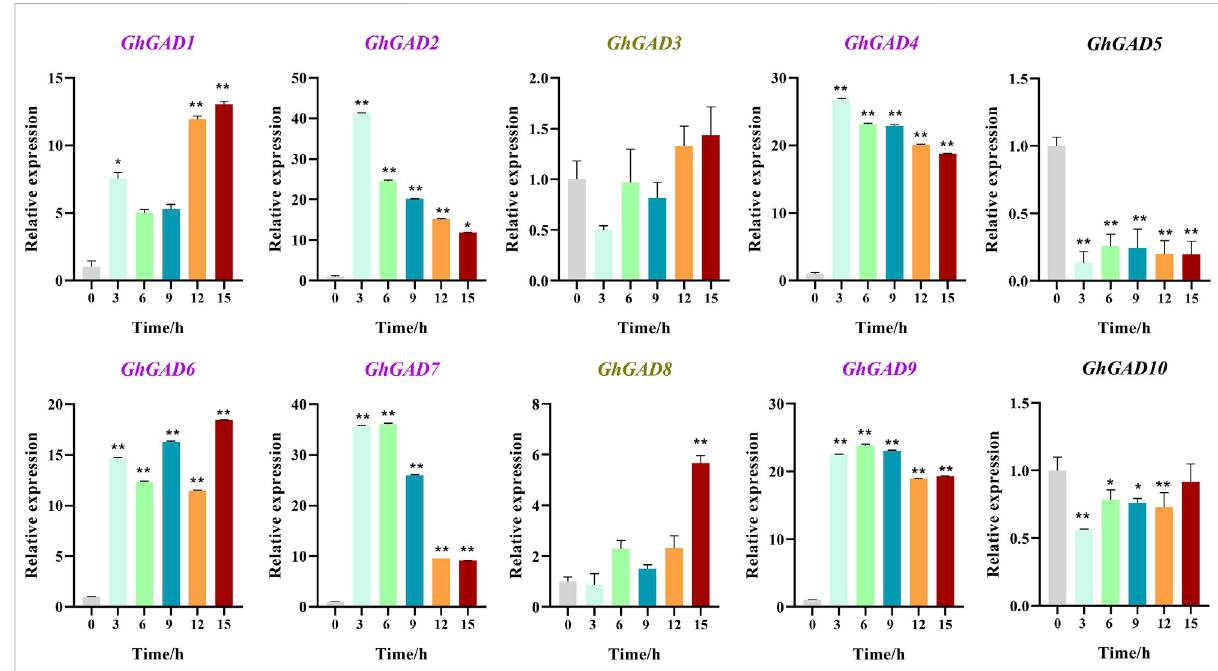
FIGURE 8 Expression analysis of GhGAD gene family at different Cd 2+ treatment times. The bar graphs represent the relative expression levels of GAD family genes in roots under Cd 2+ stress for 0, 3, 6, 9, 12, and 15 h (*0.01 < p < 0.05, ** p < 0.01); the resulting mean values were presented as relative units. Error bar represents